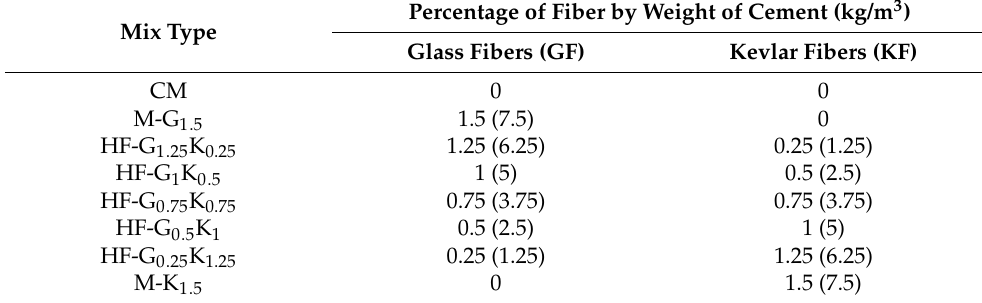
Table 4. Fiber combinations by percentage weight of